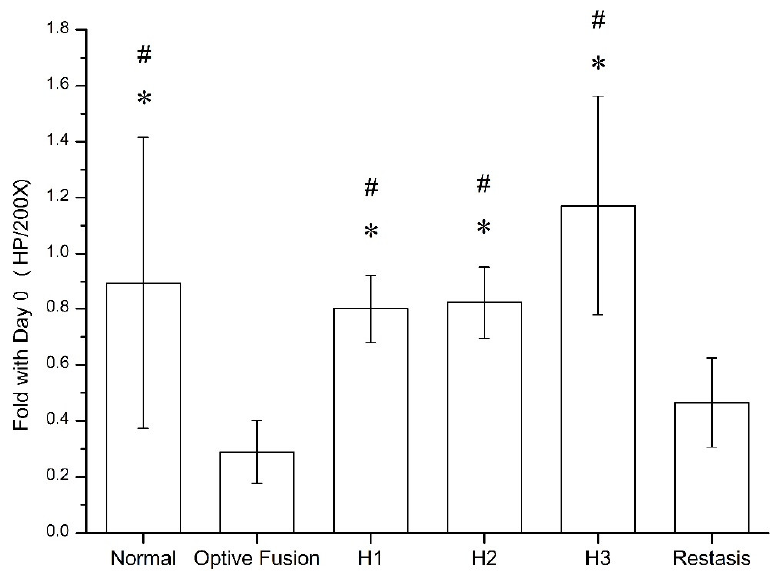
Figure 5. The ratio of goblet cell number in the normal, Optive Fusion ® , H1, H2, H3, and Restasis ® groups on day 42. Significant differences compared to Optive Fusion ® (* p < 0.05) and Restasis ® ( # p < 0.05) were observed in favor of the HA-nimesulide formulation.